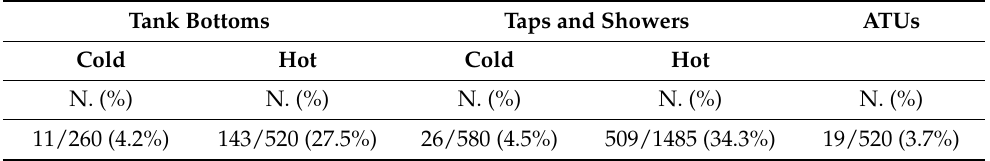
Table 2. Total samples, positive samples, and percentages for different sampling